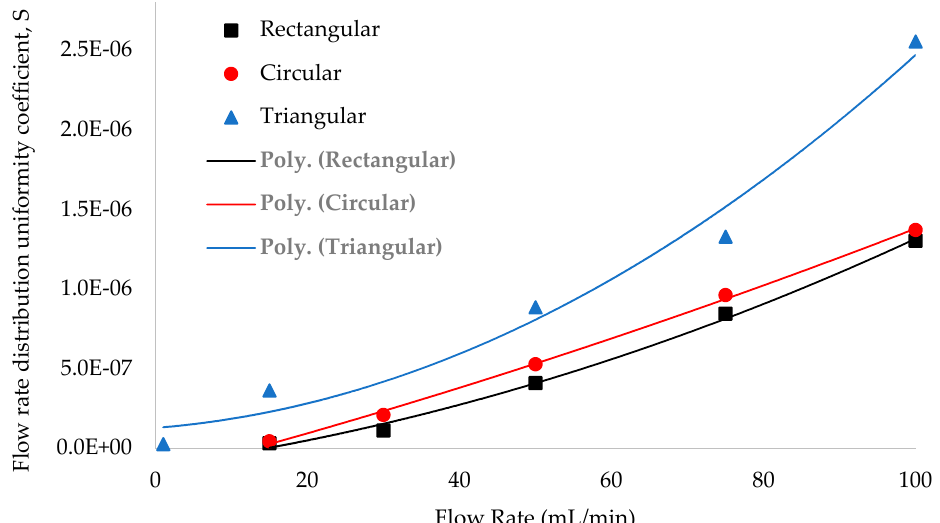
Figure 15. Influence of the shape of the collector on the FDU coefficient, S.